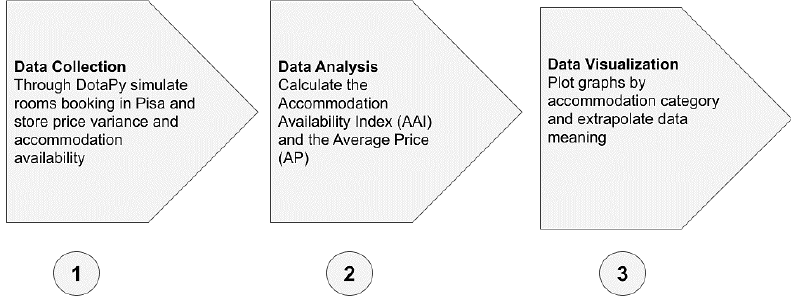
Figure 1. Research workflow